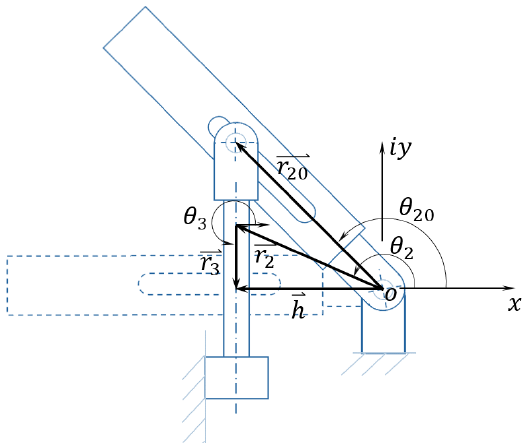
Figure 2. Mechanism kinematics of the proposed WEC.